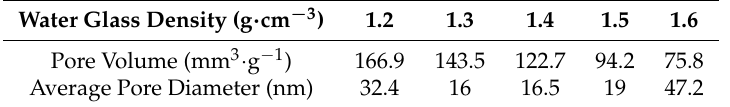
Table 4. Dependence of porosity on water glass density for geopolymers cured at ambient temperature.